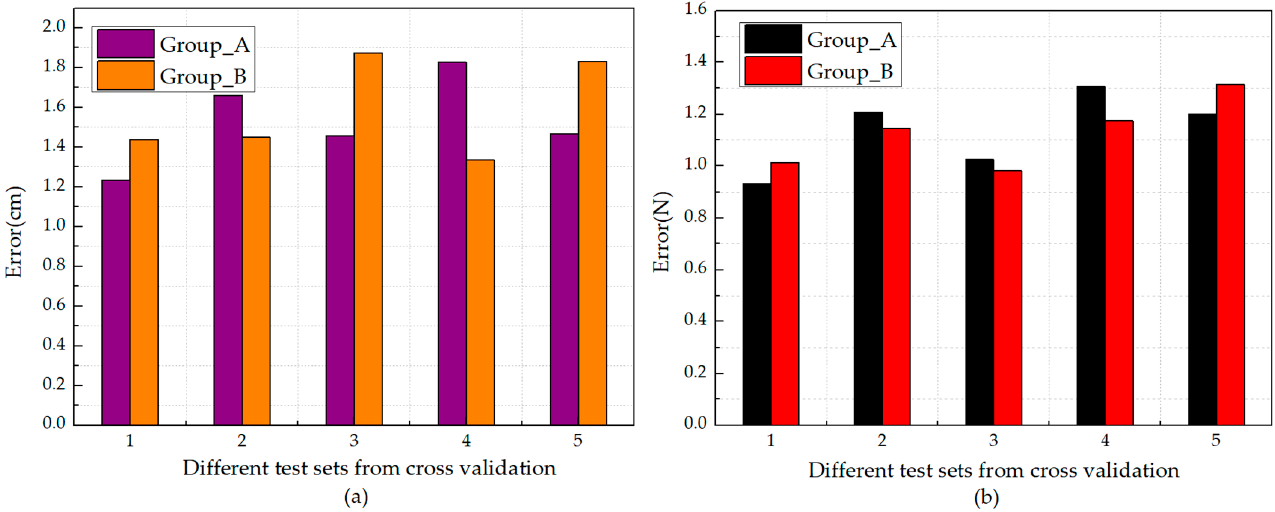
Figure 16. ( a ) Average error of location identification of impact based on five different test sets; ( b ) average error of peak value identification of impact based on the five different test sets.